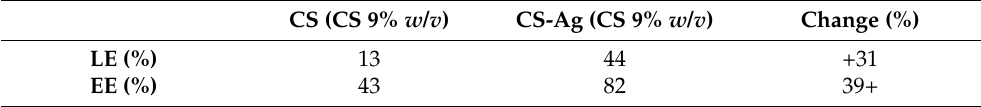
Table 4. Change in CUR LE and EE after the addition of CS. CS (CS 9% w / v ) CS-Ag (CS 9% w / v